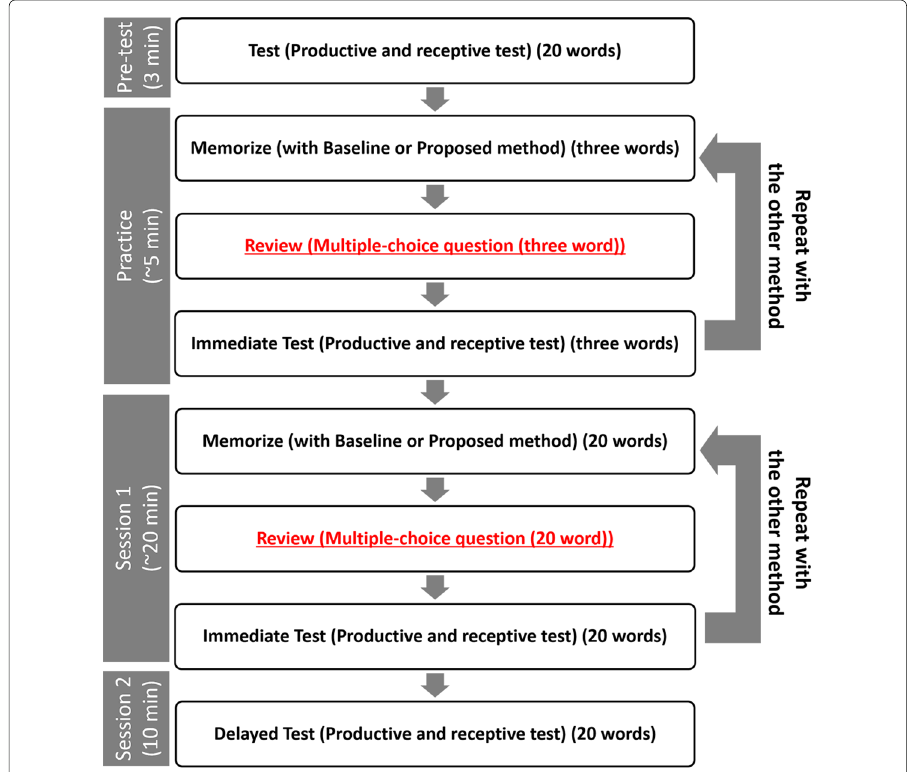
Fig. 8 Experimental procedure. The red underlined text is the additional